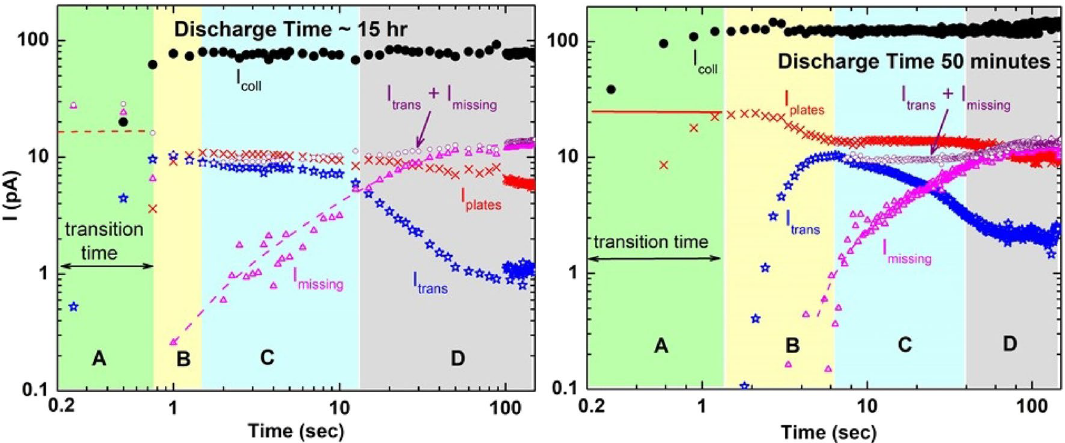
Figure 3. Currents measured at the input aperture array, I coll , (filled black circles), at the aluminum holder, I plates , (red x’s), and transmitted through the guiding assembly, I trans , (open blue stars), following a 15 h and a 50 min discharge time. In the right figure, the solid red line is an eyeball extension of the maximum value of I plates . In the left figure, the dashed red line is a similar extension with magnitude based on the 50 and 60 min discharge data. The open magenta triangles and dashed curves show an unaccounted for current, I missing , obtained via a subtraction process as described in the text. The open purple circles show I trans + I missing . The colored regions A-D indicate regions associated with various guiding processes. See text for